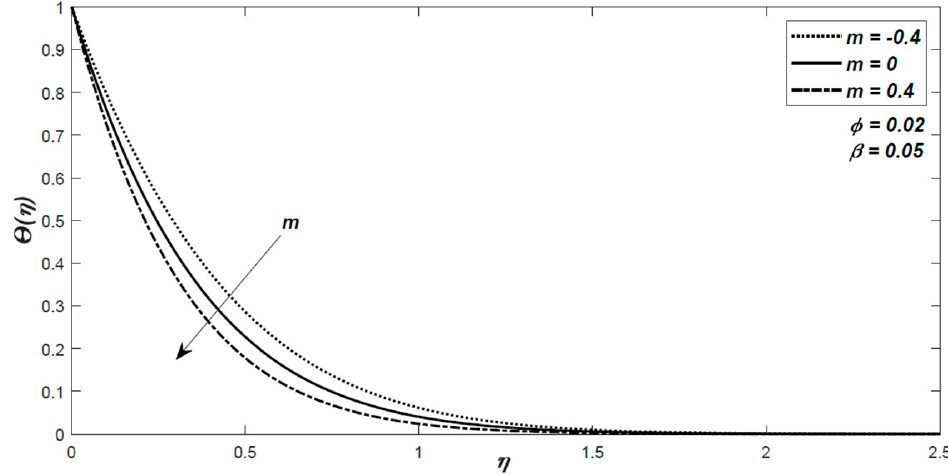
Figure 7. The variation of the nondimensional temperature for different values of the stretching parameter m